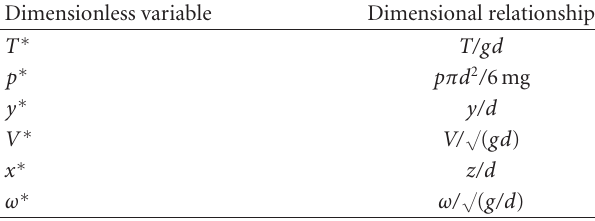
Table 1: Relationship between the dimensional and dimensionless variables.